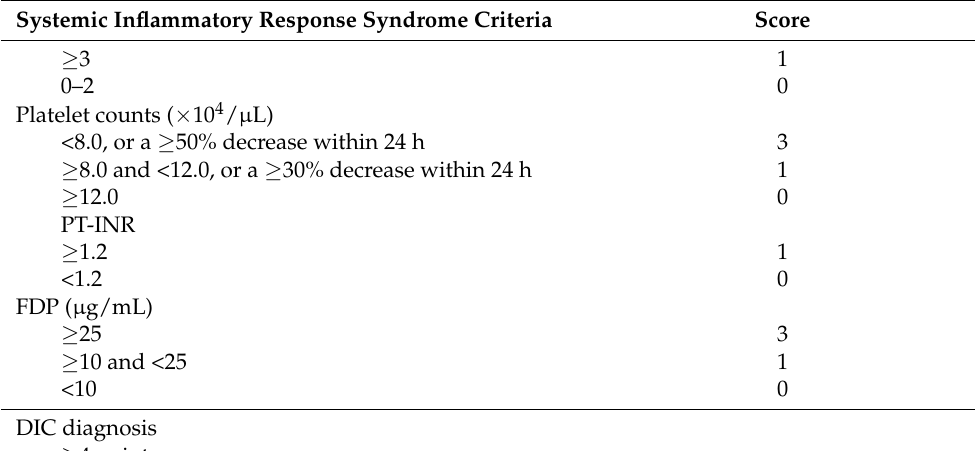
Table 1. JAAM DIC Scoring system. Systemic Inflammatory Response Syndrome